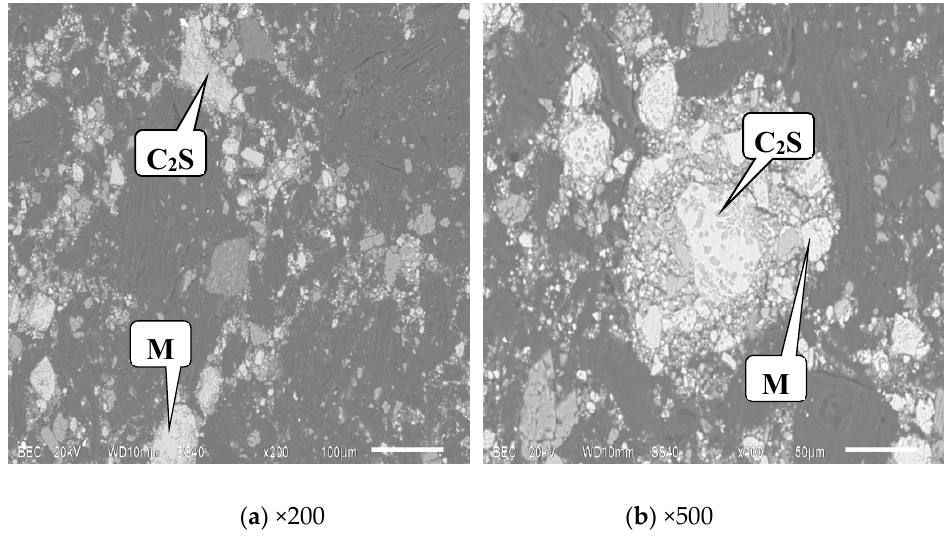
Figure 7. SEM images of the lower modified slag after grinding for 300 s.